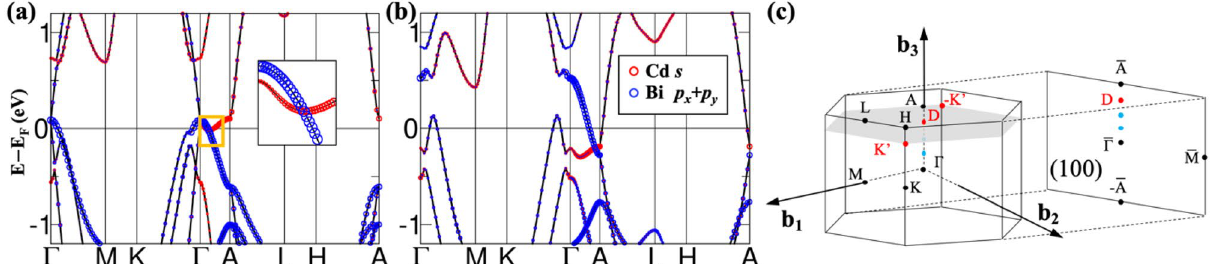
Figure 2. The band structures of bulk CaCd 2 Bi 2 under HSE06 ( a ) w/o SOC and ( b ) with SOC. The circle corresponds to the orbital contribution from Cd s orbital and Bi p x and p y orbitals indicated by red and blue, respectively. To identify the bands near Γ point of ( a ), the zoom-in diagram was provided in the inset. ( c ) The corresponding 3D first Brillouin zone (BZ) of the CaAl 2 Si 2 -type structure and the projected surface BZ at (100) plane. The high-symmetry points and Dirac points (red for CaCd 2 Bi 2 and blue for CaCd 2 SbBi) are labeled in the